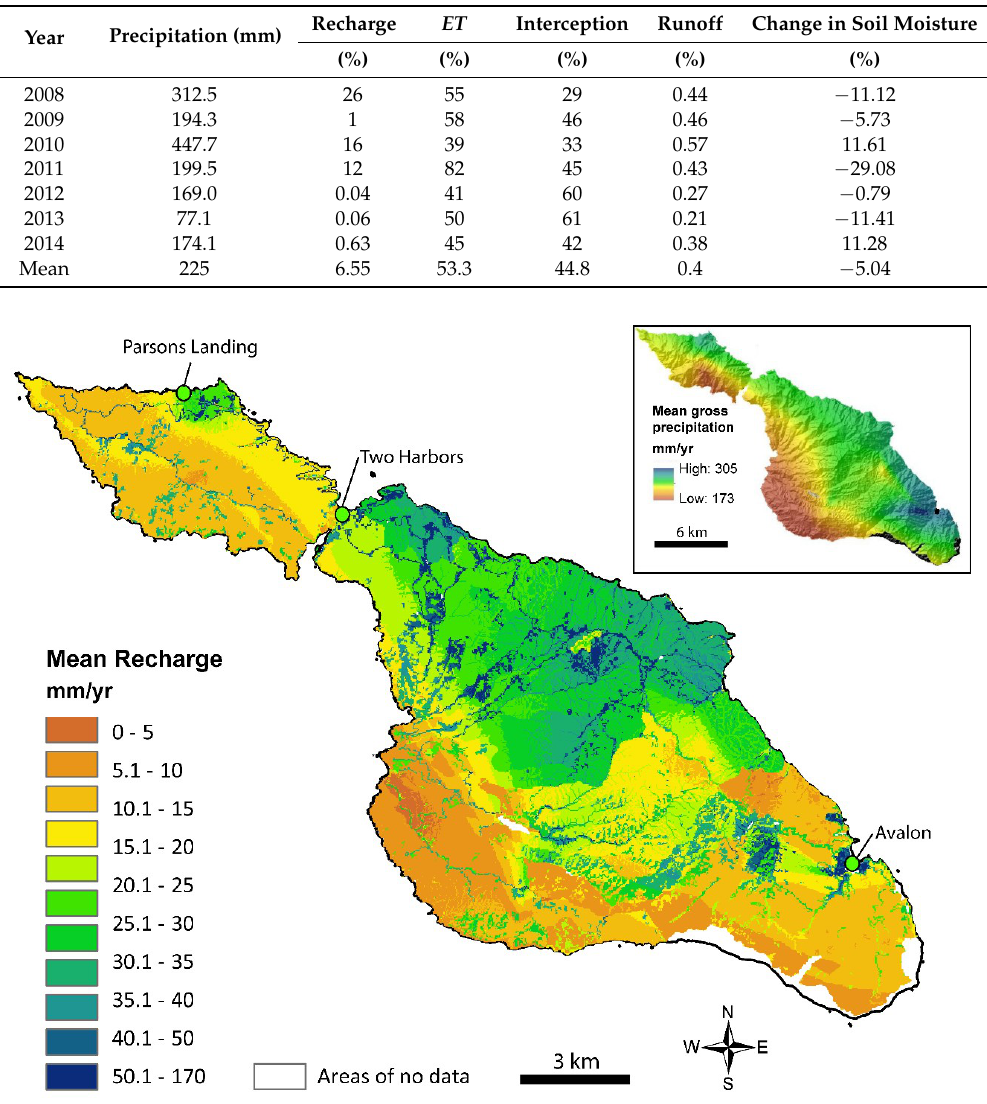
Figure 6. SWB model results of mean recharge (mm/year).